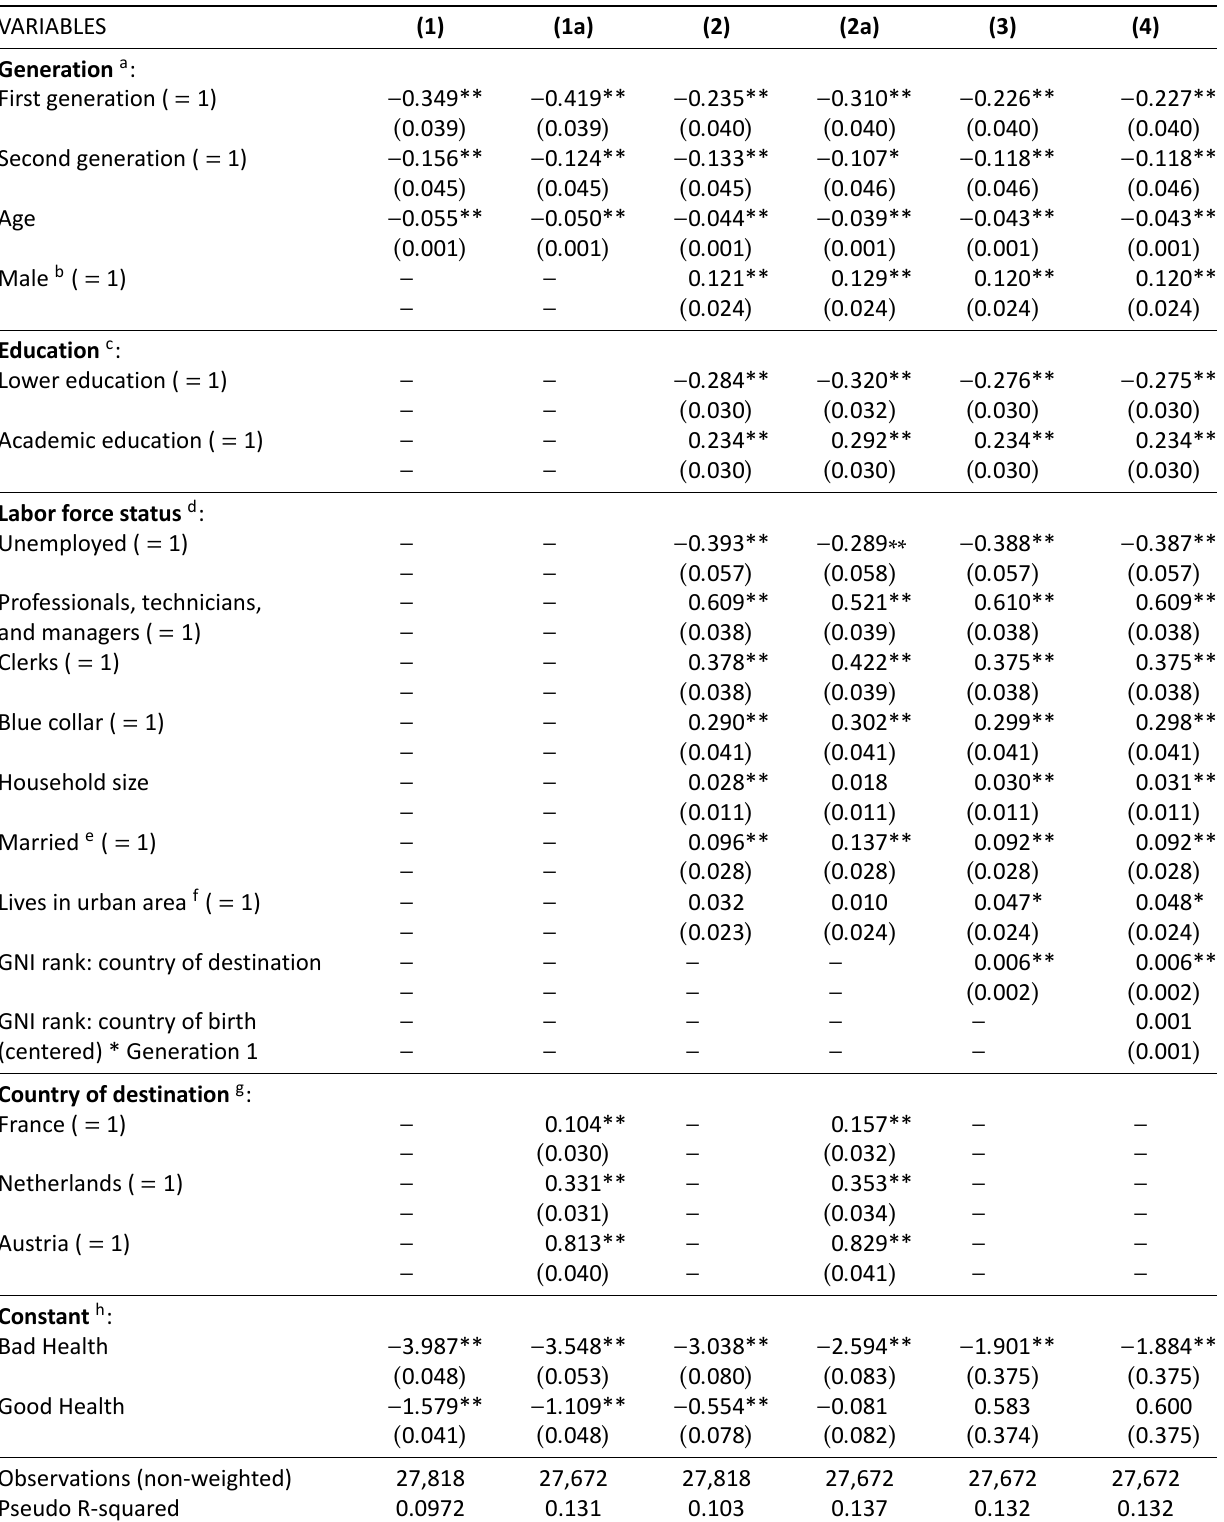
Table 3. Ordered regression predicting good general subjective health status, pooled model (dependent variable is self- perceived health , 1–3, 3 = ‘very good